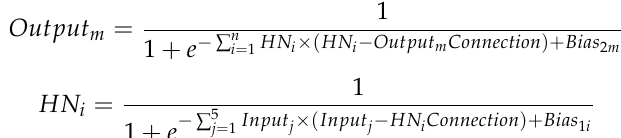
Figure 4. Schematic of 4 inputs, n hidden nodes, and 4 outputs ANN model.